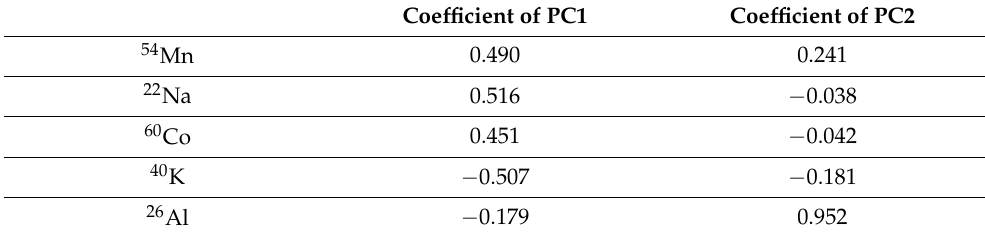
Table 4. Extracted eigenvectors.